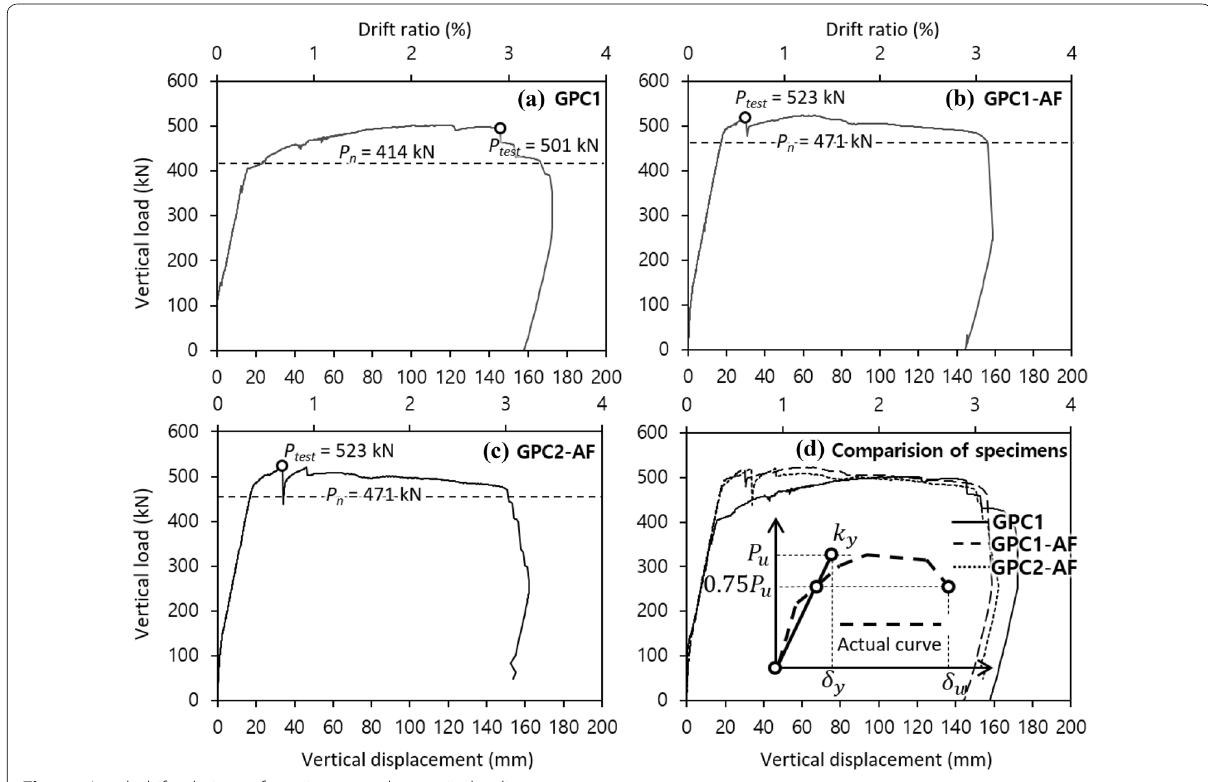
Fig. 11 Load – drift relations of specimens under gravity